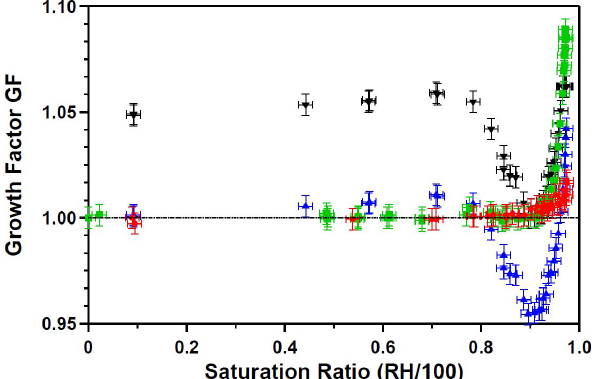
Fig. 8. Humidograms of calcium carbonate aerosols size selected Figure 8. Humidograms of calcium carbonate aerosols size selected at an electromobility at an electromobility diameter of 150nm. CaCO 3 (red dots), diameter of 150 nm. CaCO 3 (red dots), Ca(HCO 3 ) 2 (blue triangles), Ca(HCO 3 ) 2 normalized to Ca(HCO 3 ) 2 (blue triangles), Ca(HCO 3 ) 2 normalized to the min- the minimum diameter at RH 89.5% (black triangles), and Ca(HCO 3 ) 2 pre-conditioned at imum diameter at RH 89.5% (black triangles), and Ca(HCO 3 ) 2 100%RH and dried before size selection (green squares). Measurement errors: saturation ratio pre-conditioned at 100% RH and dried before size selection (green ±0.014, GF ±0.005. squares). Measurement errors: saturation ratio ± 0 . 014, GF ± 0 .